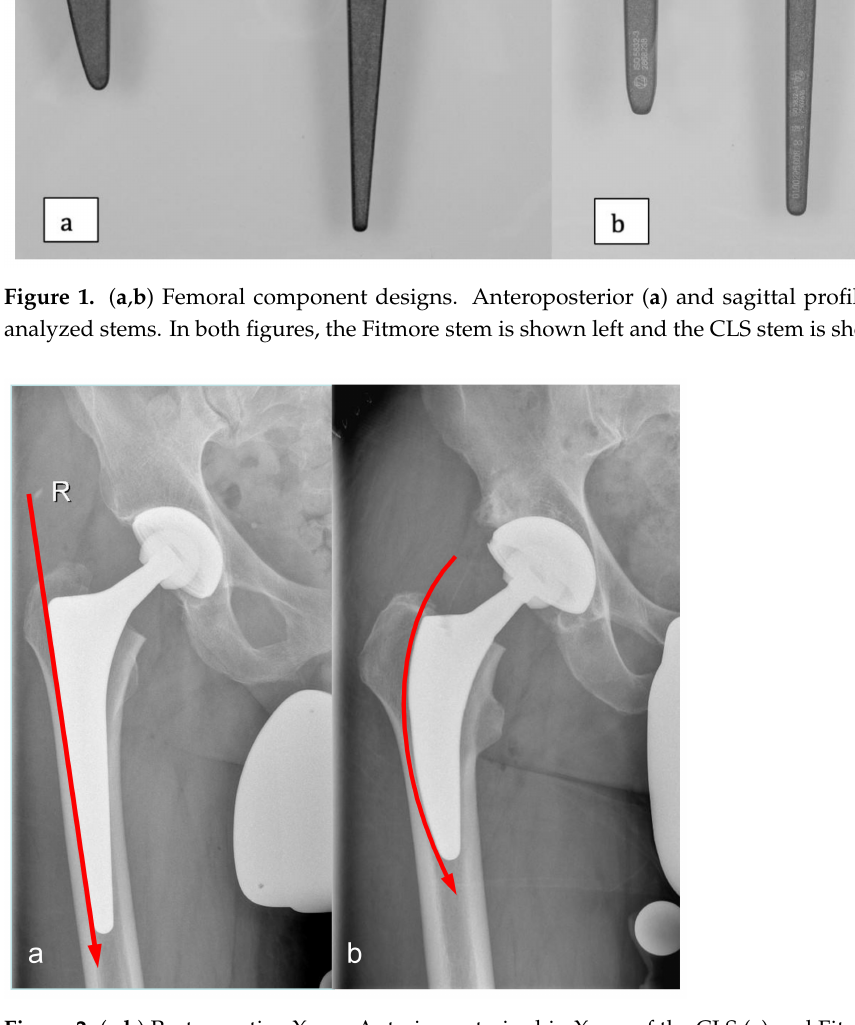
Figure 2. ( a , b ) Postoperative X-ray. Anterio-posterior hip X-ray of the CLS ( a ) and Fitmore ( b ) stem. Displayed lines illustrate the trochanter sparing geometry of the Fitmore stem during the implantation